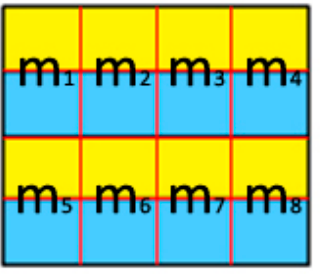
Figure 4 . Dividing the composite model into parts . Figure 4. Dividing the composite model into